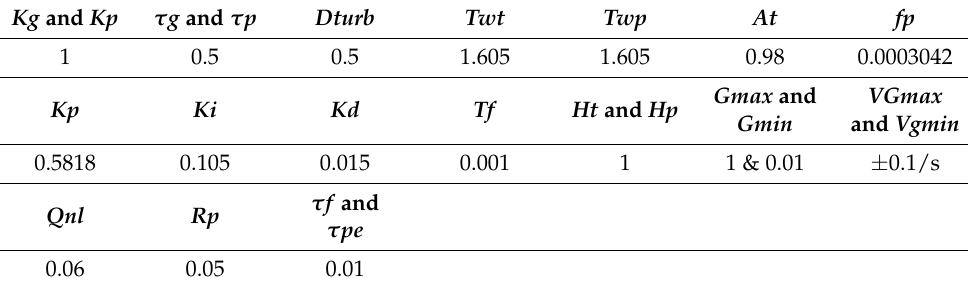
Table A3. Governor turbine system parameters referring to Figure